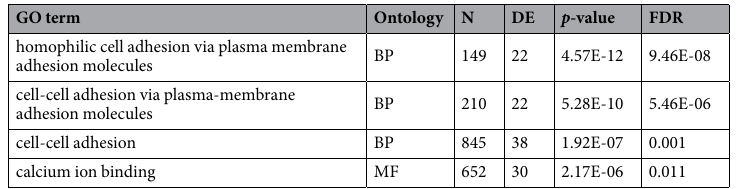
GO term Ontology N